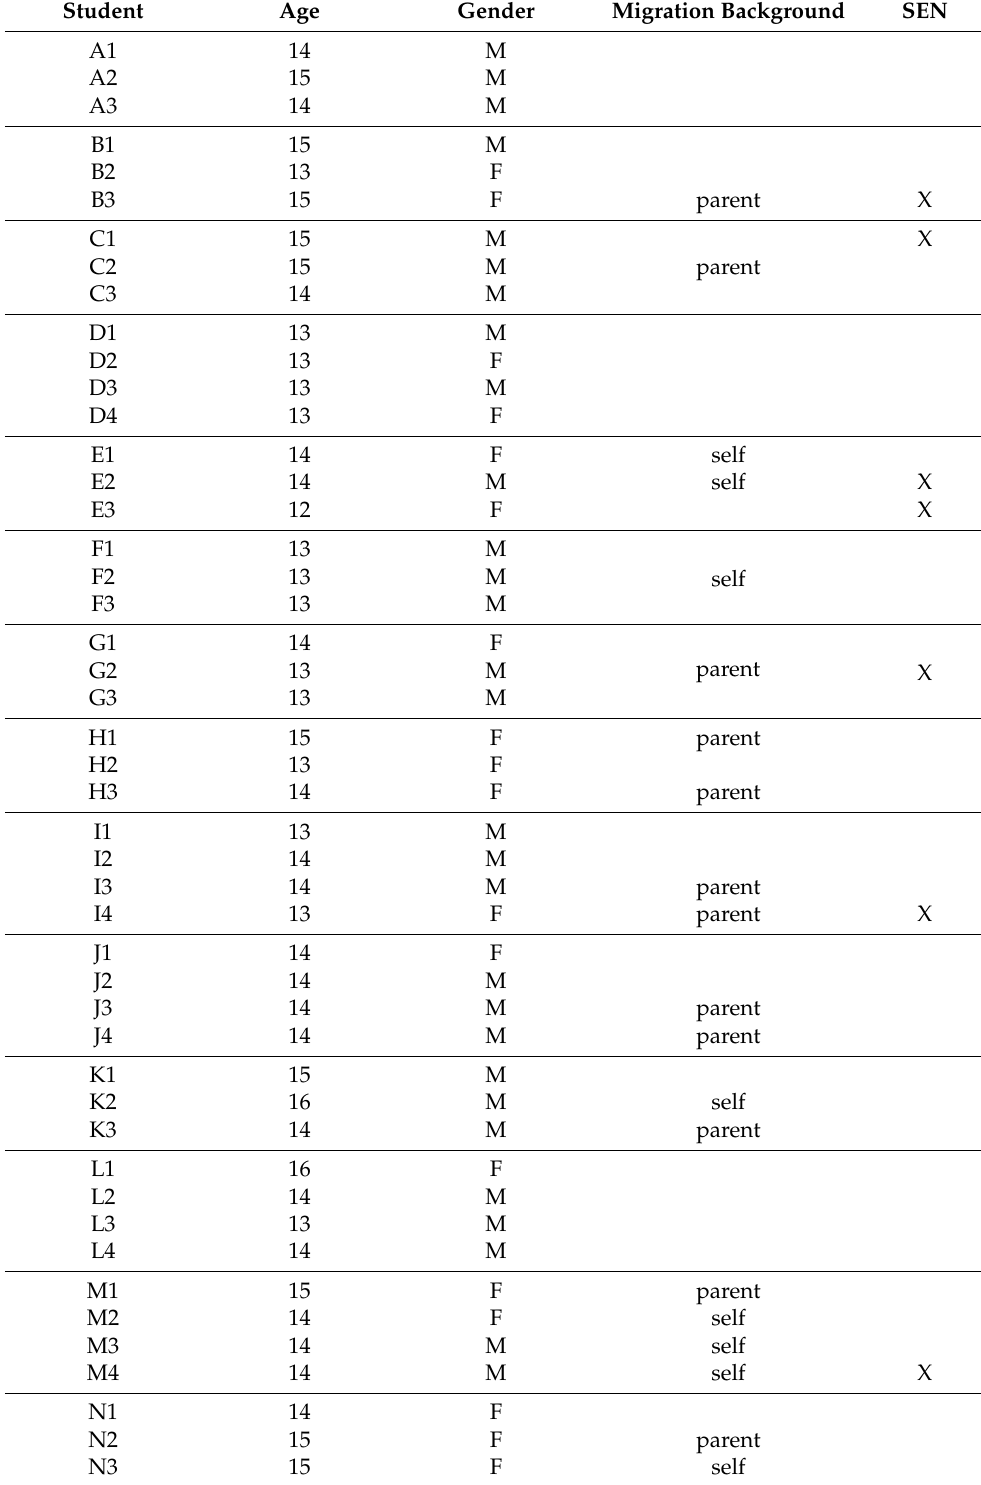
Table 1. Overview of the participating students and their sociodemographic data, according to the